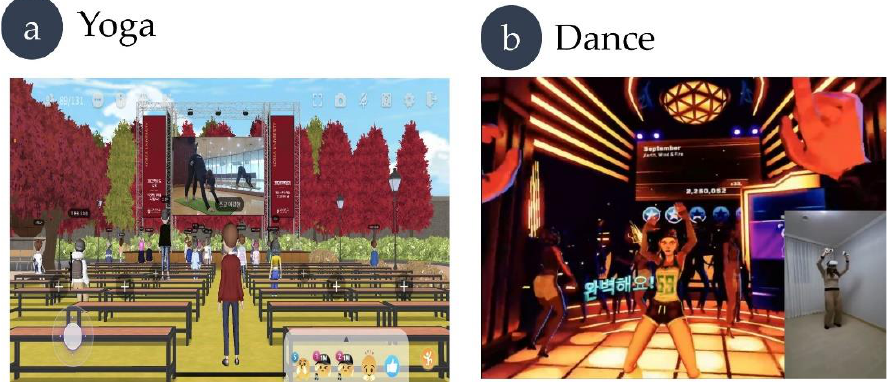
Figure 5. Practical physical education in virtual reality.